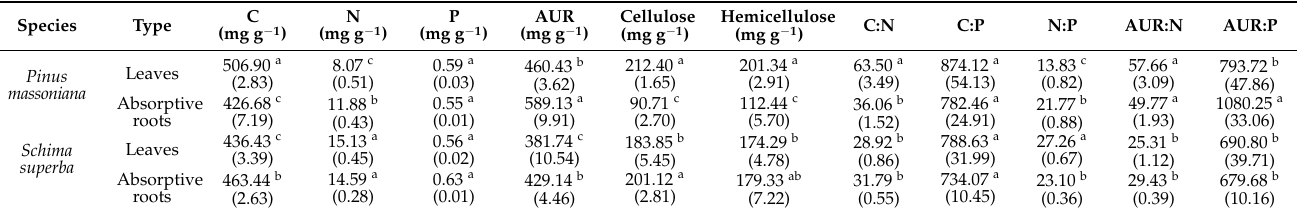
Table 1. Initial chemistry of the four substrates used in this study.